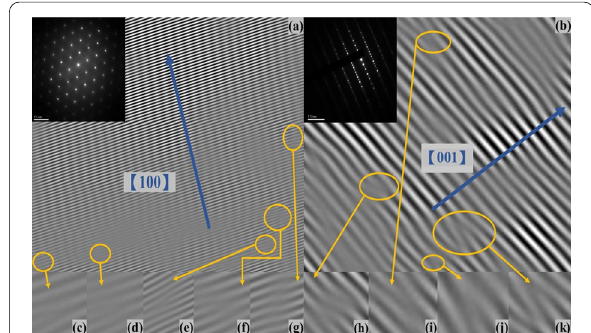
Fig. 6 a and b The high‑resolution transmission electron microscope image of the WSe 2 single crystals in different axes and planes. The insets are the reciprocal lattice image of selected area electron diffraction patterns of the WSe 2 single crystals in different axes and planes. c – k reveal lattice dislocation of the WSe 2 single crystals at several locations in different axes and planes